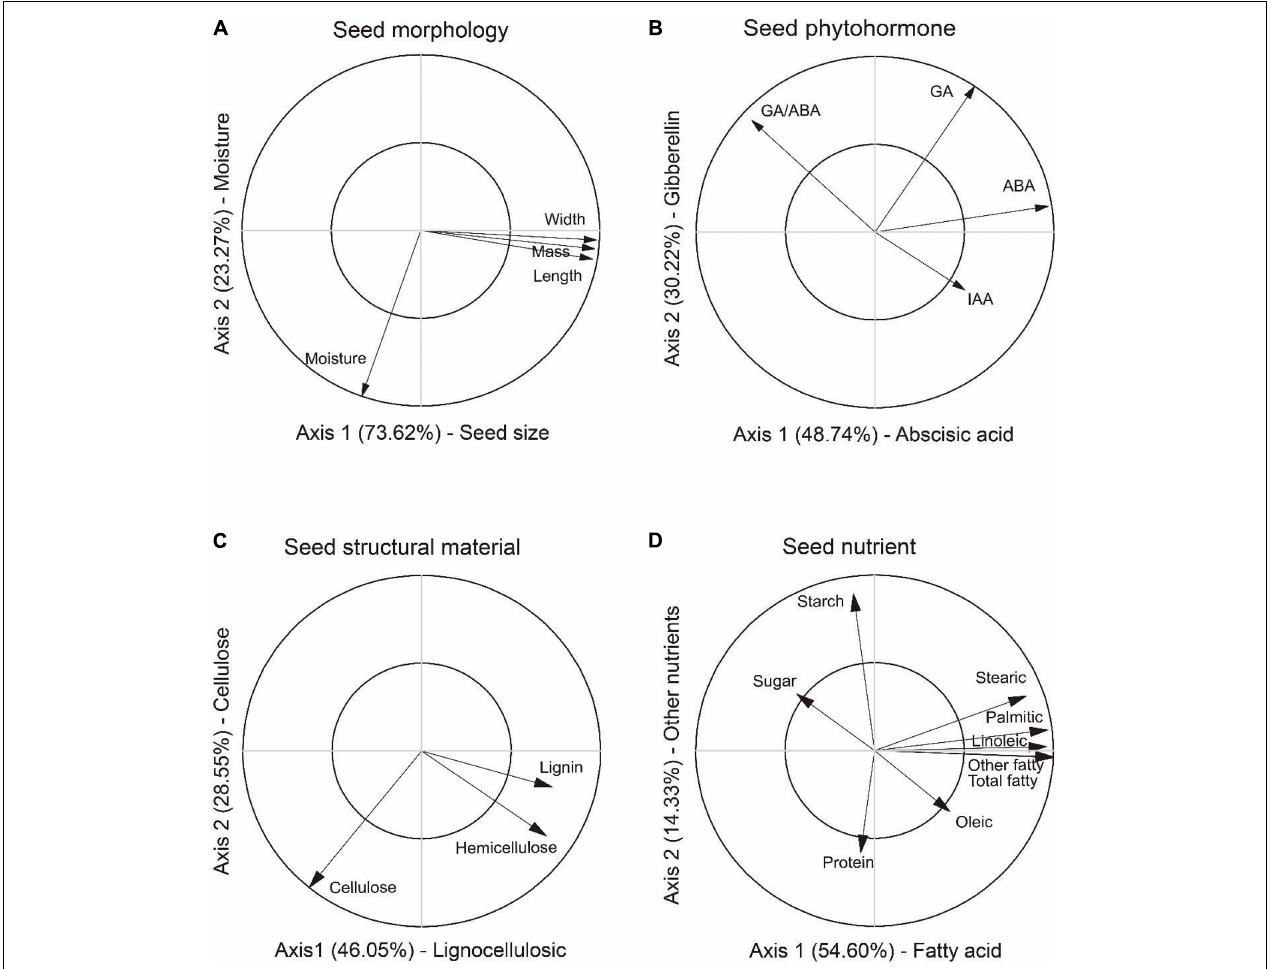
FIGURE 2 | Principal component analysis for variables in morphology (PCA M ), phytohormone (PCA P ), structural material (PCA S ) and nutrients (PCA N ) in seed of Ambrosia artemisiifolia . The first two axes in PCA M (A) were characterized as composite measures of “Seed size” and “Moisture,” respectively. The first two axes in PCA P (B) were defined as composite measures of “Abscisic acid” and “Gibberellin,” respectively. In the PCA S (C) , the first two axes were represented as composite measures of “Lingocellulosic” and “Cellulose,” respectively. In the PCA N (D) , the first two axes were characterized as composite measures of “Fatty acid” and “Other nutrient,” respectively. PCA axes were used as representative variables for further analyses. Note only the significant relationships were shown in the